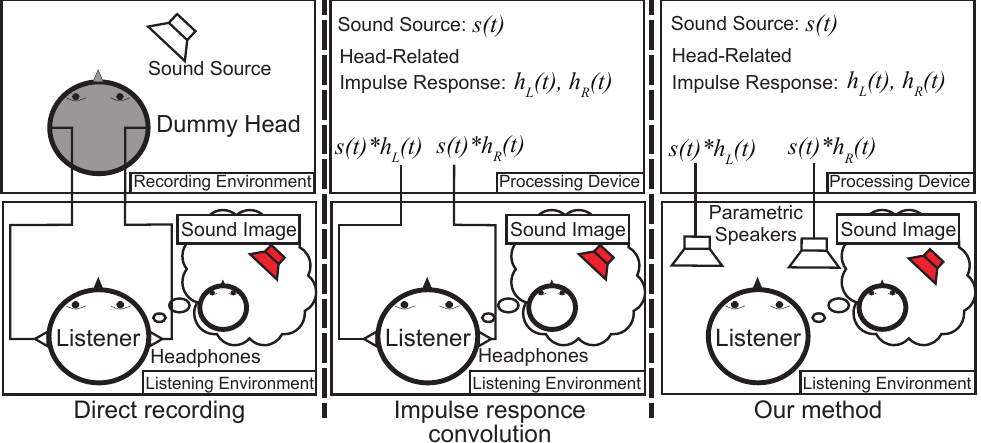
Figure 4. Method for providing localization to a sound